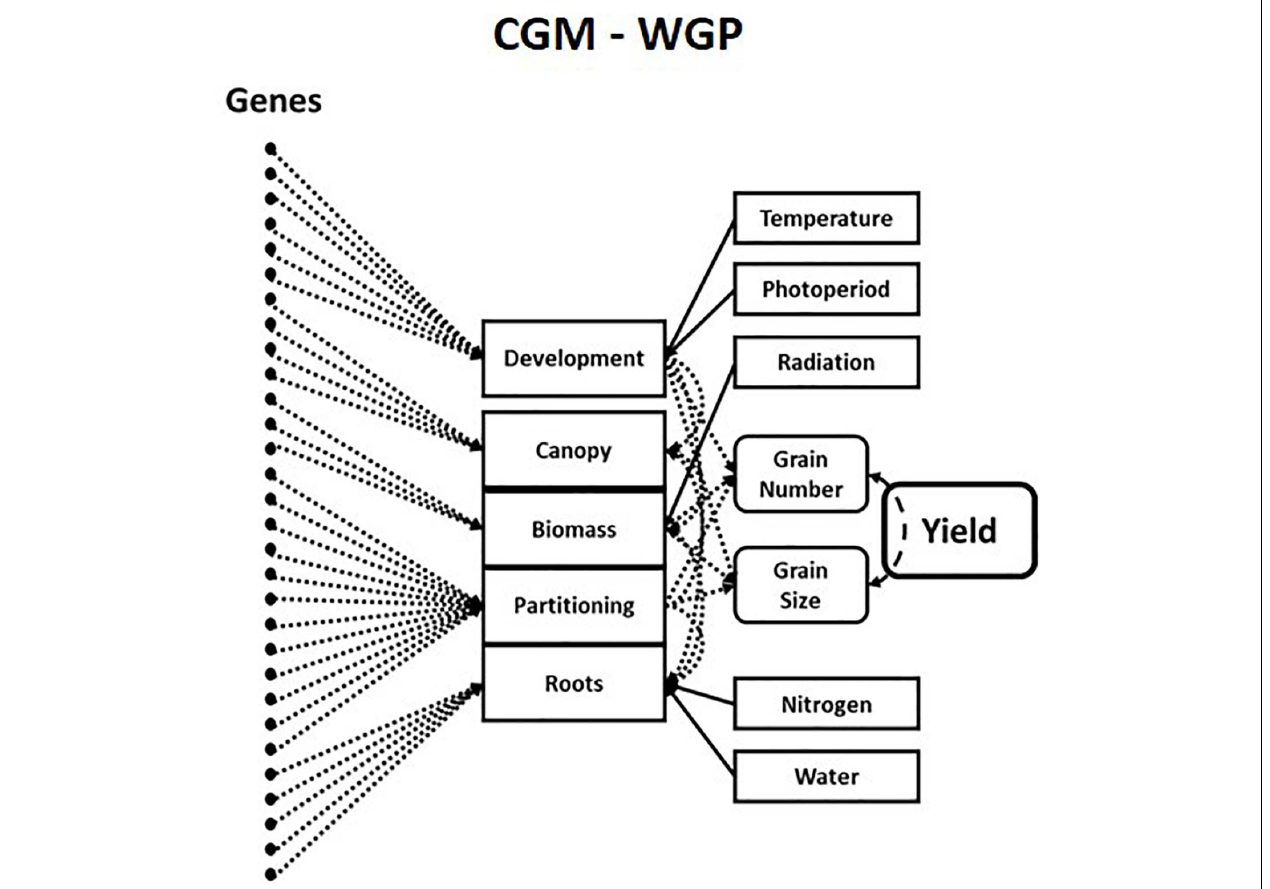
FIGURE 2 | Schematic representation of a hierarchical crop growth model whole genome prediction (CGM-WGP) G2P map. Taken from Figure 2b of Cooper et al. (2020a). Genetic variants are associated with traits or “meta-mechanisms” at lower levels in the crop growth model hierarchy to predict traits at higher levels in the